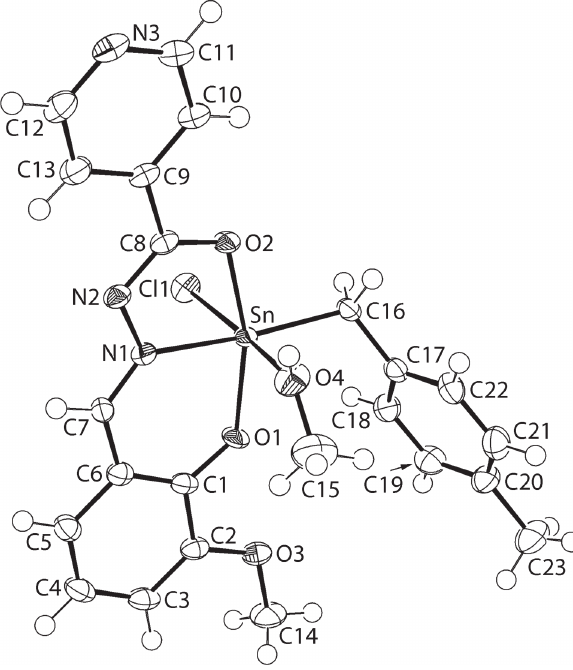
Table 1: Data collection and